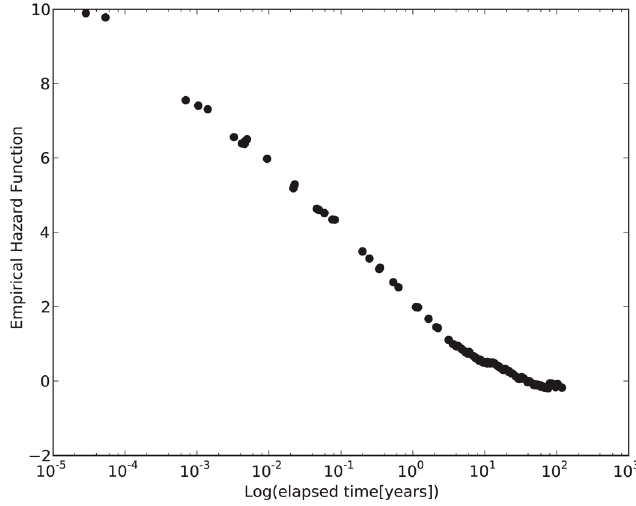
Figure 3. Plot of the residuals of the model as a function of the time elapsed since the most recent event (CT). The residuals mimic the time behavior of the m ( t ). 0